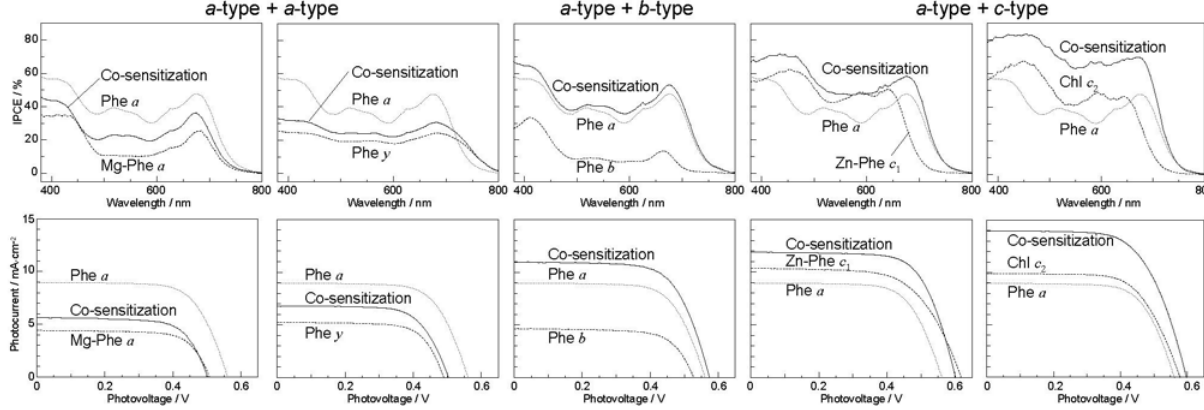
( J = 10.4, η = 4.0) and Chl c (Mg-Phe 1 sc 2 and Chl 1 and Q transitions defined x y